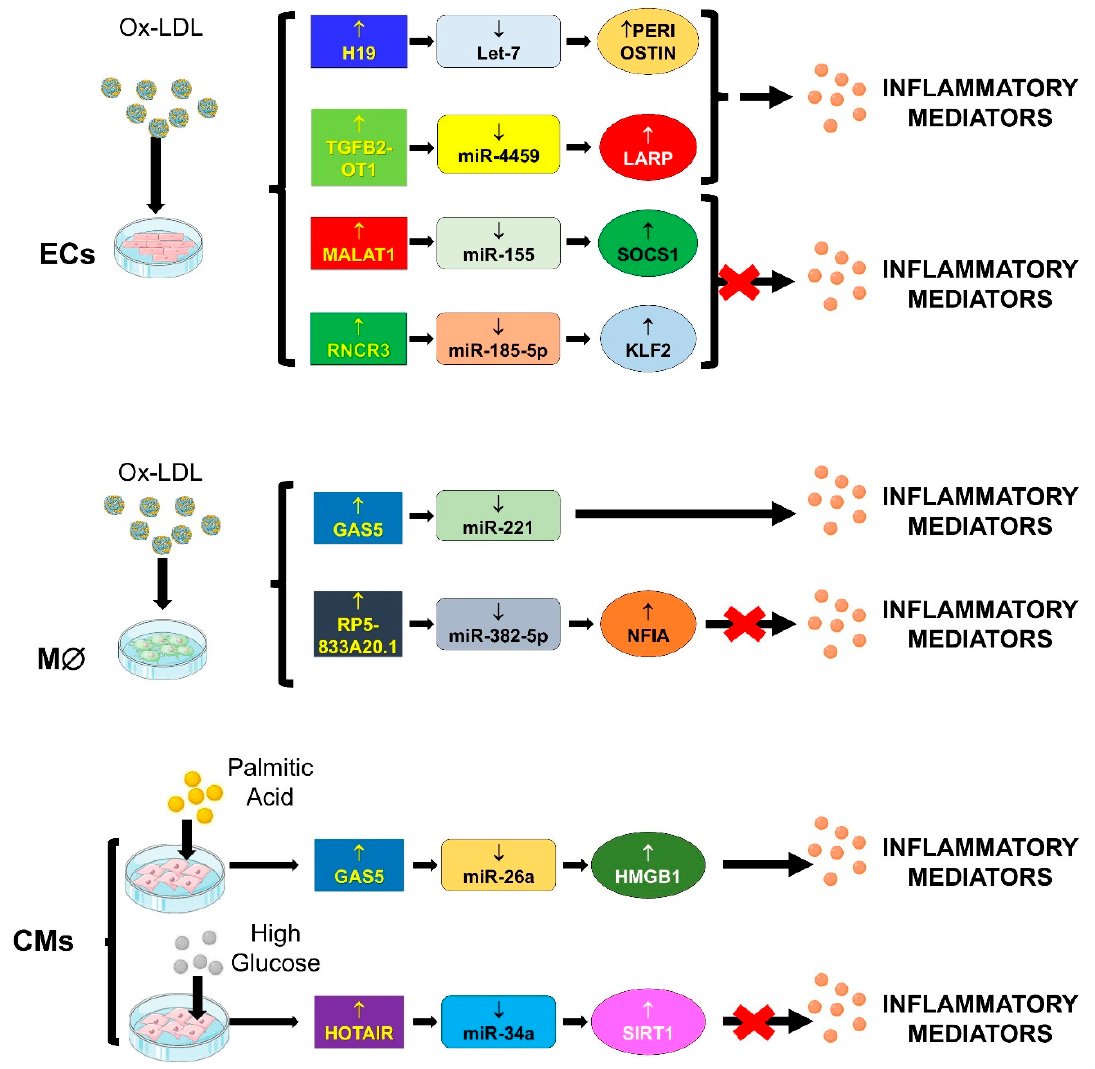
Figure 4. LncRNA-miRNA-mRNA networks and inflammation. During ageing, there is an increased accumulation of inflammatory molecules as well as a burst in oxidative stress. A prolonged state of inflammation can be detrimental for cardiovascular tissue and it can predispose to atherogenesis. Indeed, an increase in inflammatory cytokines and chemokines leads to the internalization of oxidized lipoproteins (ox-LDL) with transformation in foam cells, both contributing to tissue injury. The figure summarizes in vitro experiments performed in endothelial cells (ECs), macrophages cells (M ∅ ) and cardiomyocytes (CMs).